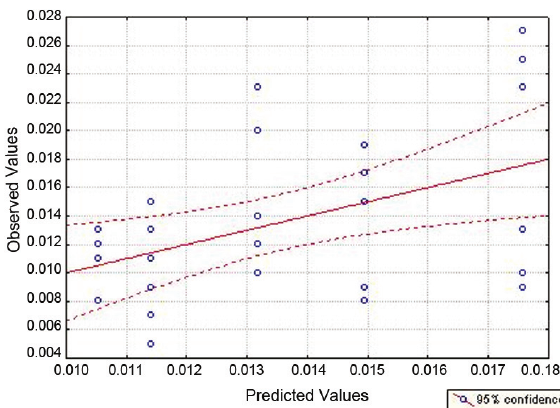
fig. 12. the dependency of the average electrical conductivity on heating time for media 12, 13 and 14